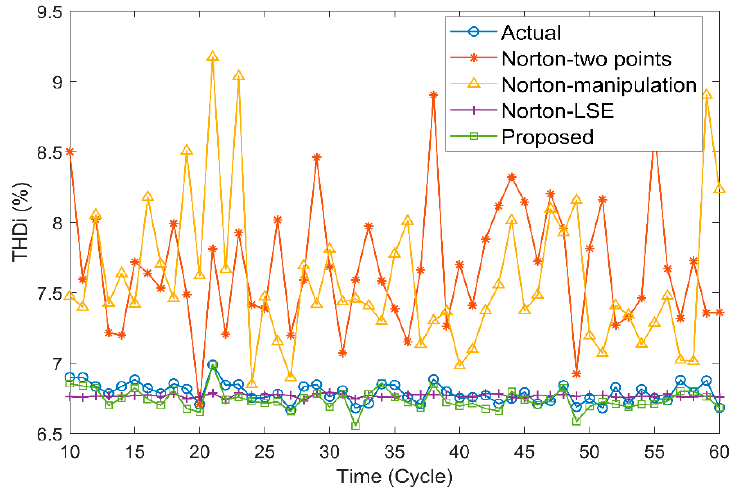
Figure 10. Comparisons of estimation of THDi by proposed method and Norton-based methods.